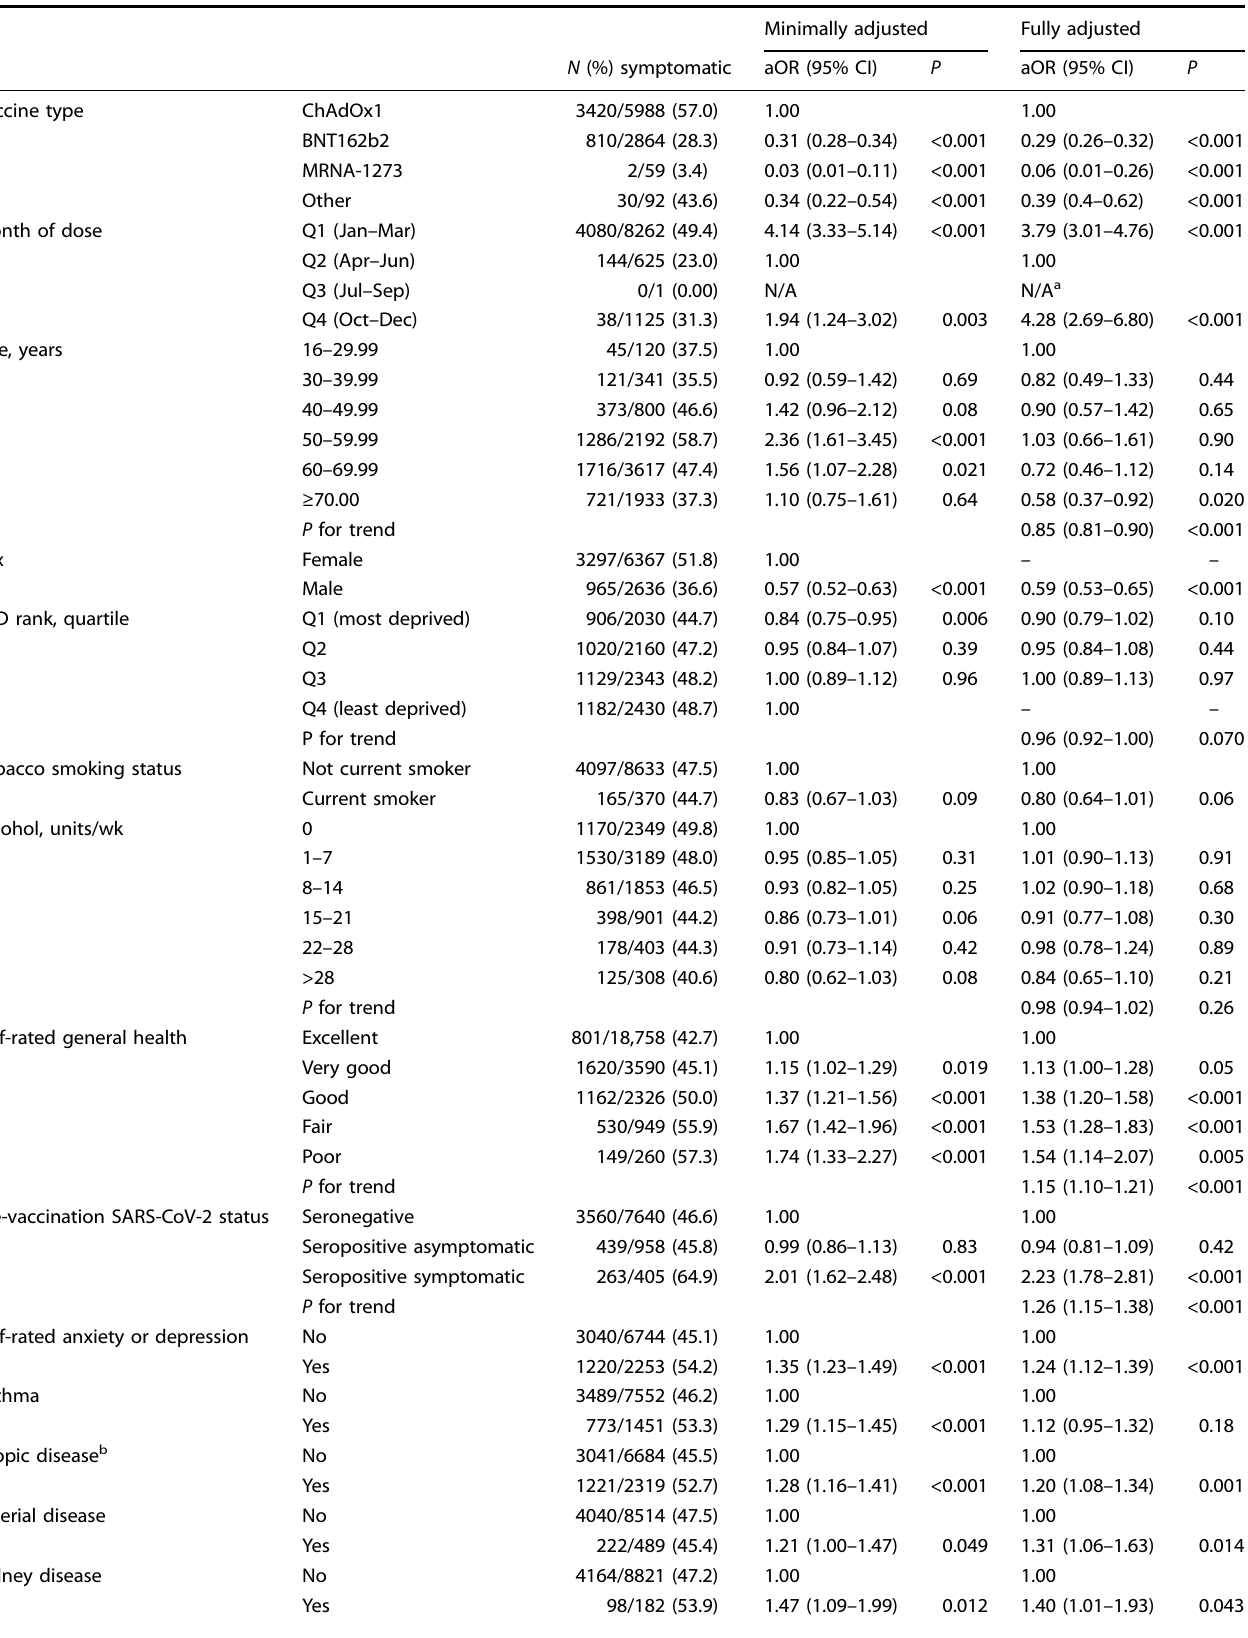
Table 2. Incidence and determinants of systemic reactive symptoms after a fi rst dose of SARS-CoV-2